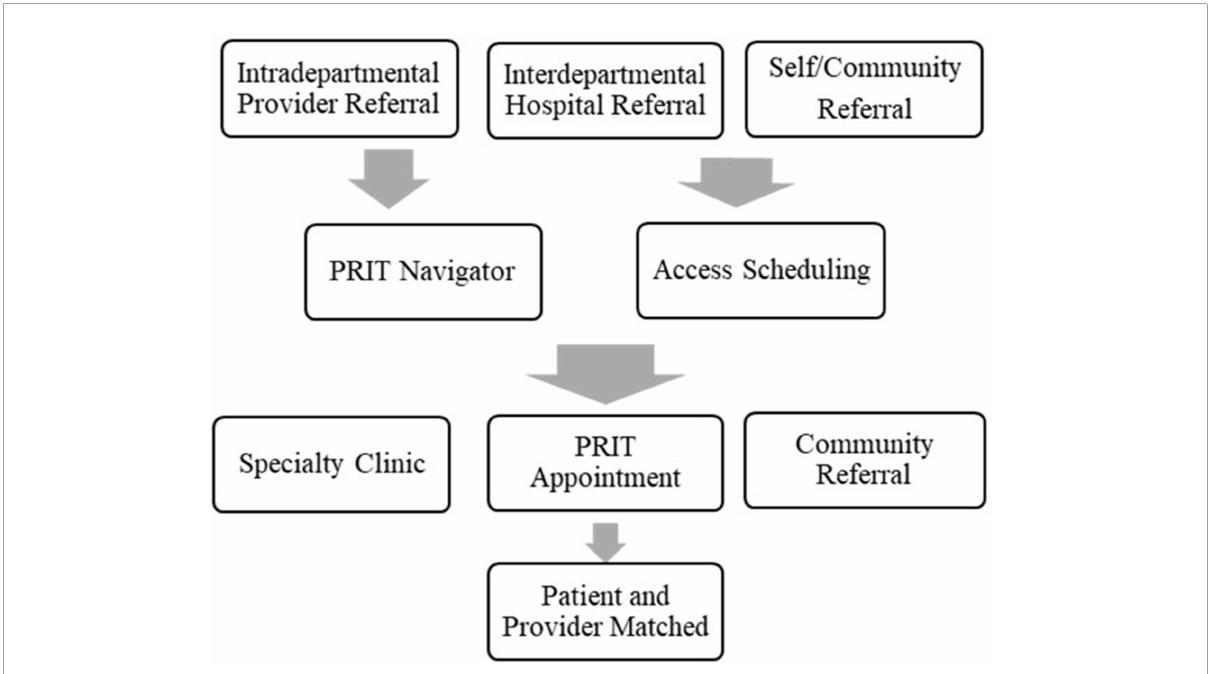
FIGURE2 Psychology rapid intake team appointment